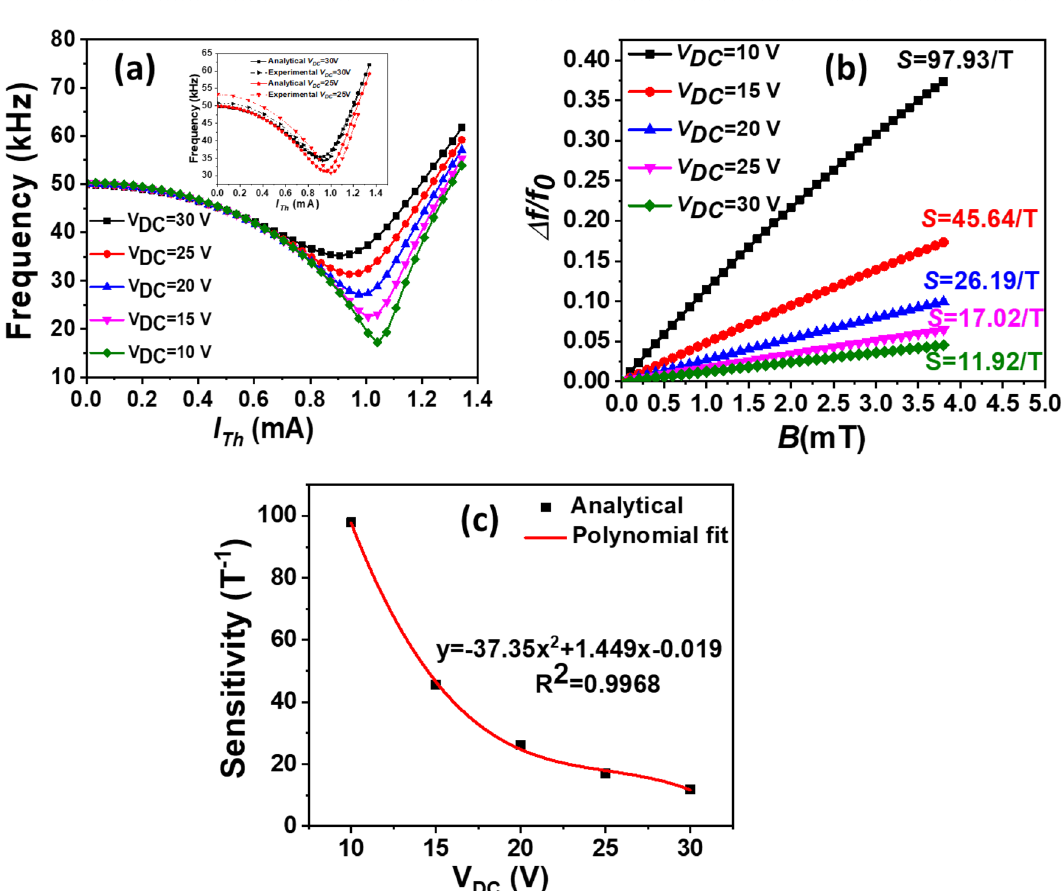
Figure 6. ( a ) Analytical results of the resonance frequency variation of the micro-beam with I Th for various values of V DC . The inset shows the analytical and experimental variation of the resonance frequency for different I Th for V DC = 30 V and 25 V. ( b ) Results of the normalized resonance frequency variation versus B for different bias V DC . ( c ) Results of the variation of S versus V DC